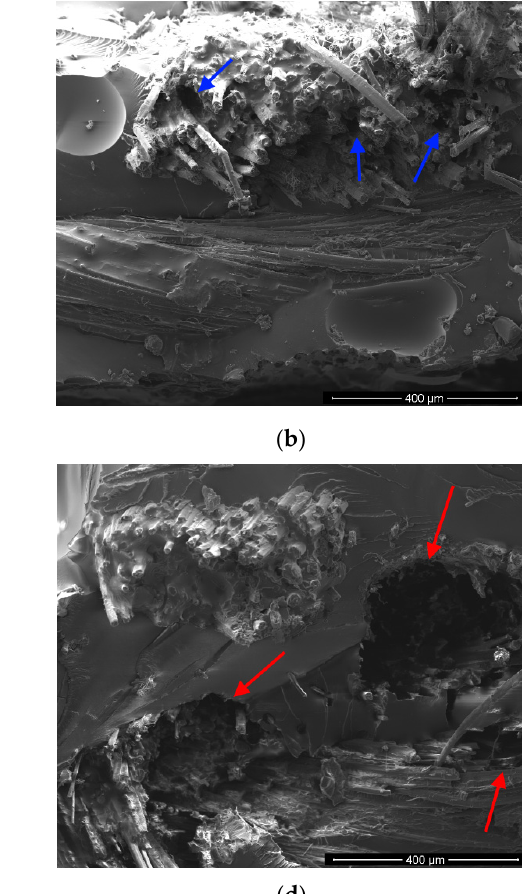
Figure 9. SEM micrographs at low magnification (250×) of tensile fractured surfaces: ( a ) R, ( b ) C5, ( c ) C10 and ( d ) C20 composites.